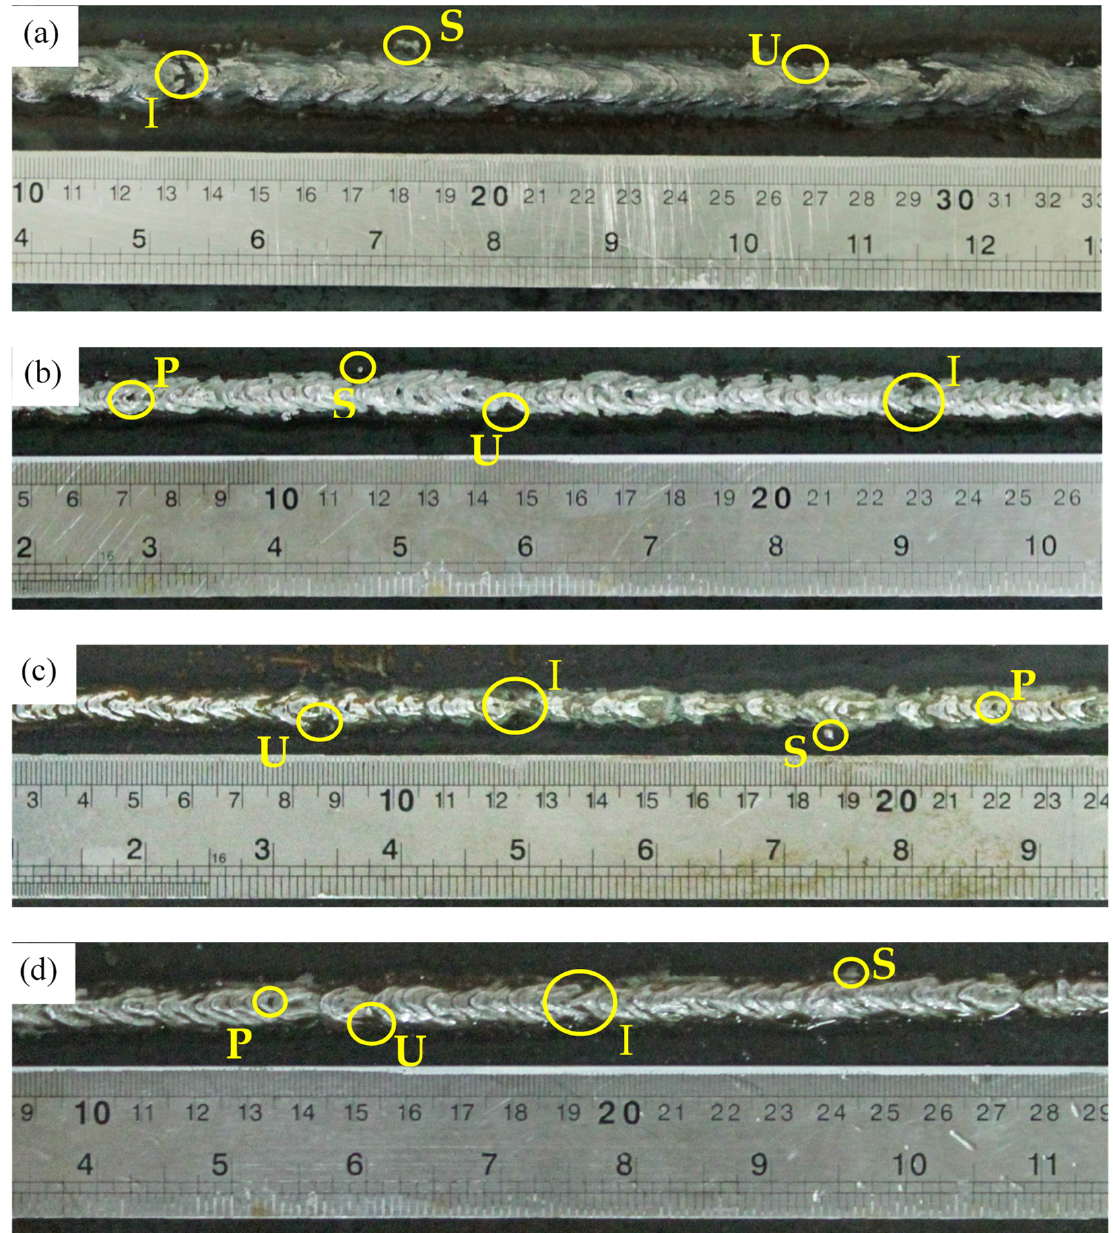
Figure 4. Results for specimens exposed to: ( a ) air welding, ( b ) flowless welding, ( c ) non-uniform flow welding with a baffle bulkhead, and ( d ) non-uniform welding without a baffle bulhead.